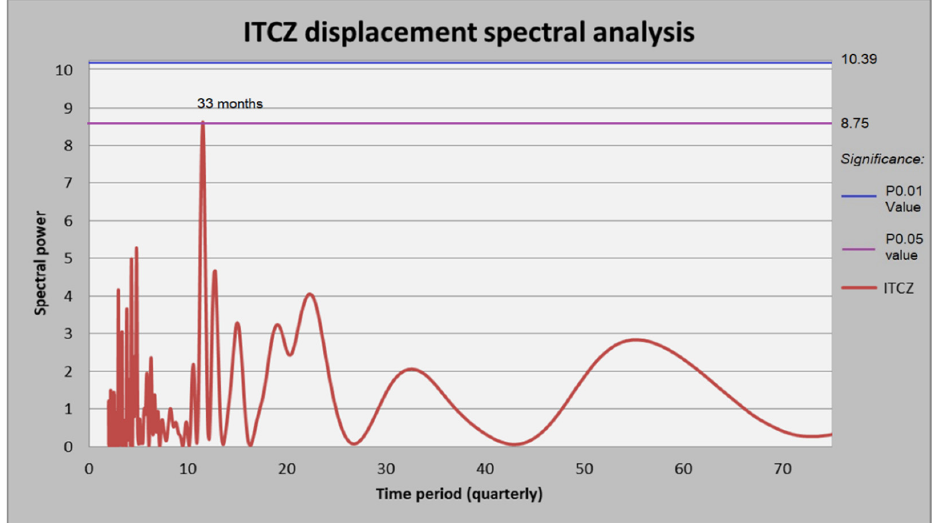
Figure 6. Spectral analysis of the latitudinal shifts of the ITCZ for the period 1979–2005 on a quarterly scale. The red line represents the variability of the spectral power, while the blue line represents the minimum value of significance P0.01 (10.39) and the purple line represents the minimum value of P0.05 (8.75).